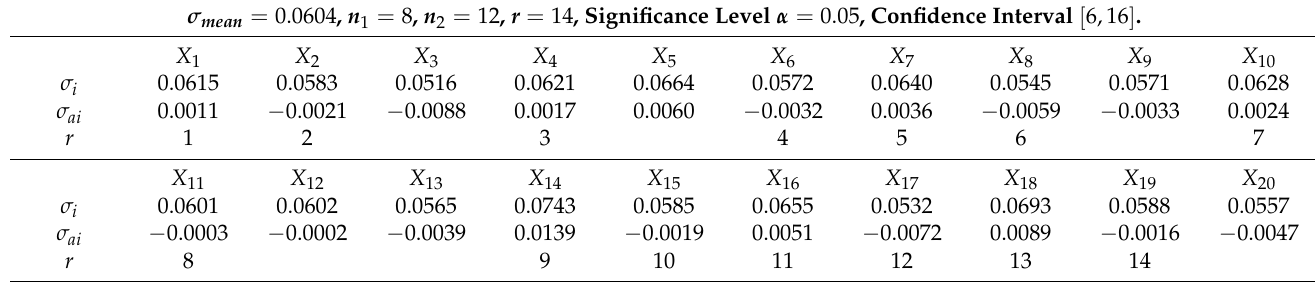
Table 1. Run test process of x -axis raw